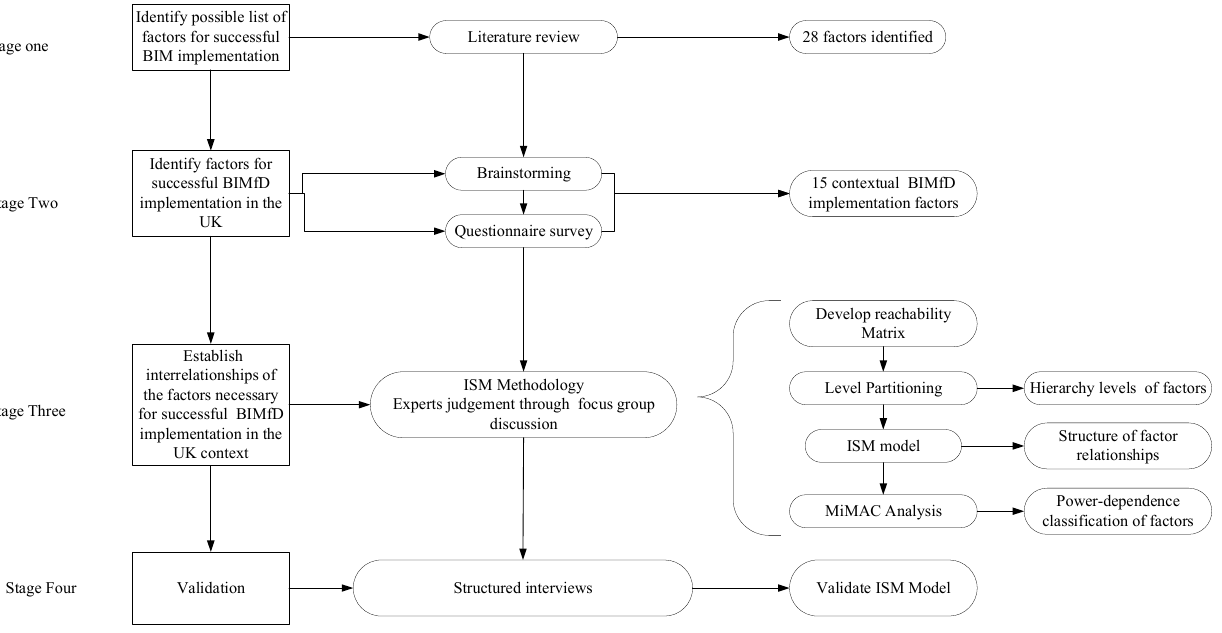
Figure 1. Four-stage research protocol.